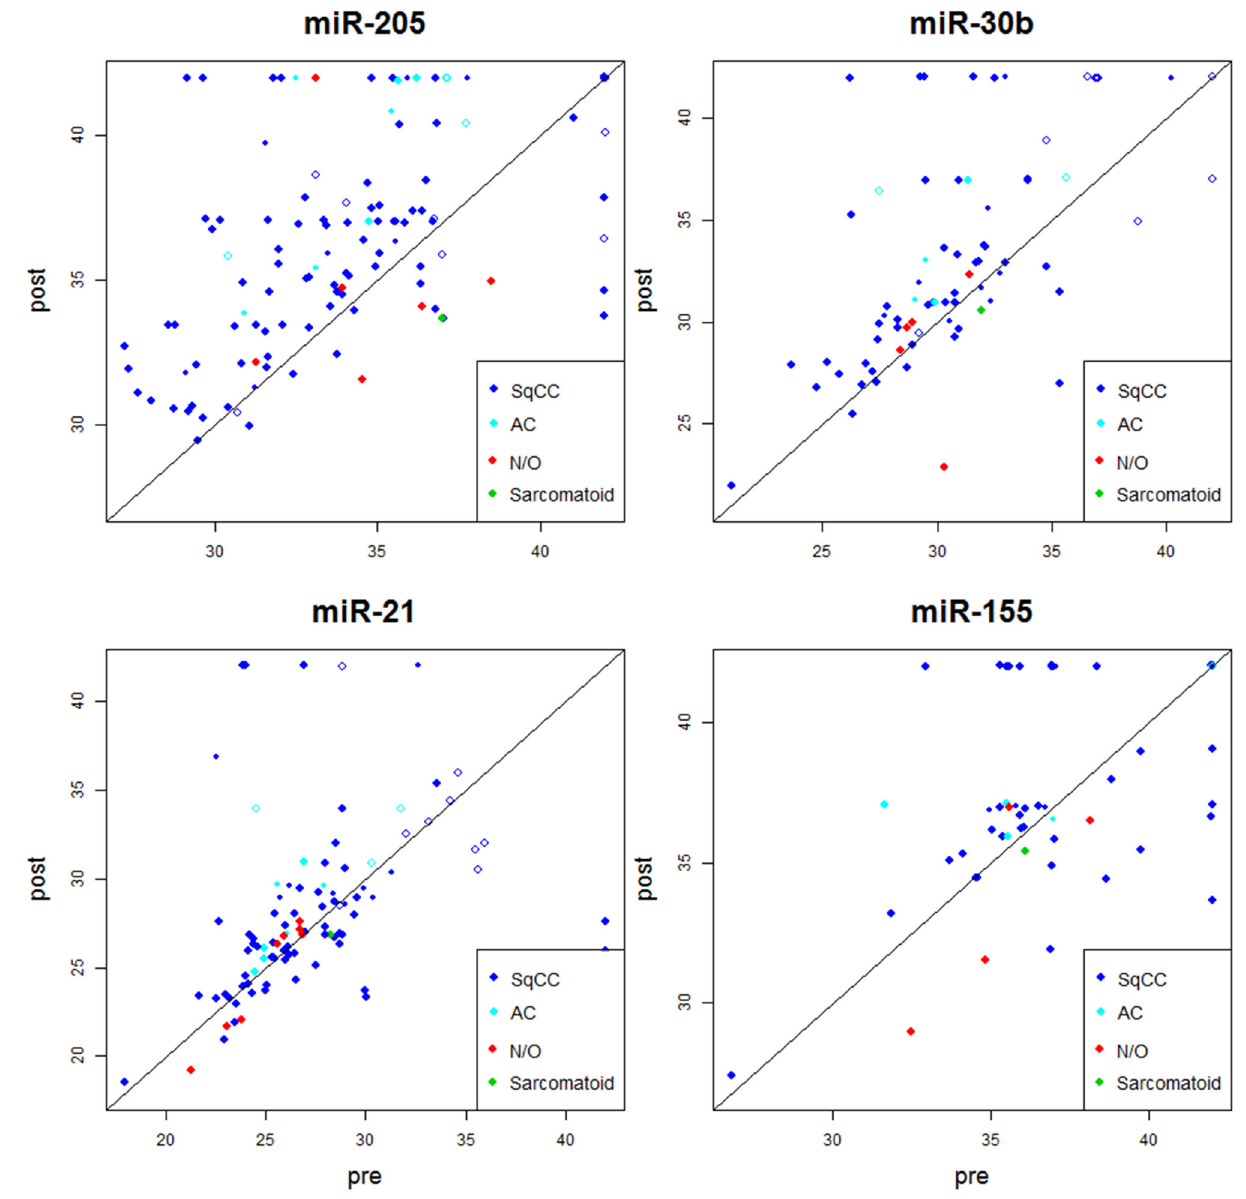
Figure 2. Examples of miRNAs for which levels decreased markedly after tumor removal (upper panel) and of those for which levels did not change significantly (lower panel). SqCC - squamous cell carcinoma, AC – adenocarcinoma, N/O – non- oncological